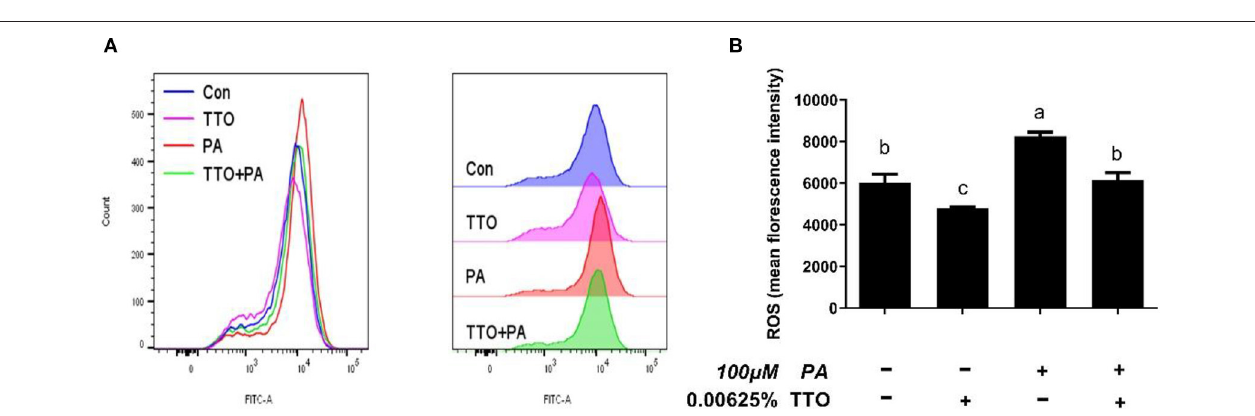
FIGURE 5 | Expression of genes related to endoplasmic reticulum stress in bovine hepatocytes treated with TTO (0.00625%) and/or PA (100 µ M). Expression of genes related to endoplasmic reticulum stress, normalized by GAPDH. All results are expressed as the mean ± SEM. The letters above the error bars indicate that the difference between groups was significant ( P < 0.05). These data are representative of three independent experiments.